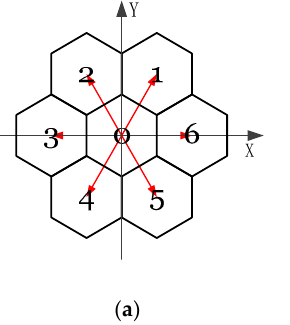
Figure 7. Two types of cell directions for the mixed aperture 3 and 4 hexagonal grids on the plane and the digits are marked for each basic vector of cell direction (source—own study).